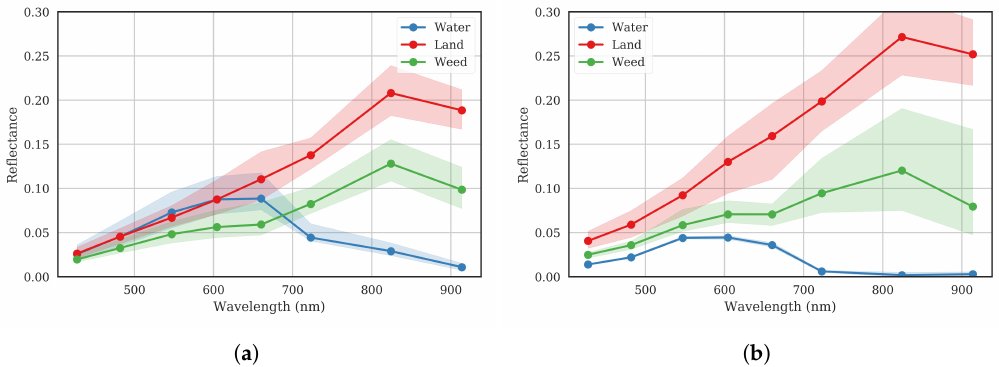
Figure 9. Reflectances of samples from each of the defined class polygons in the WorldView-3 images. The lines shows the median reflectances and the shaded areas the 25–75th percentiles. ( a ) 2017 image; ( b ) 2018